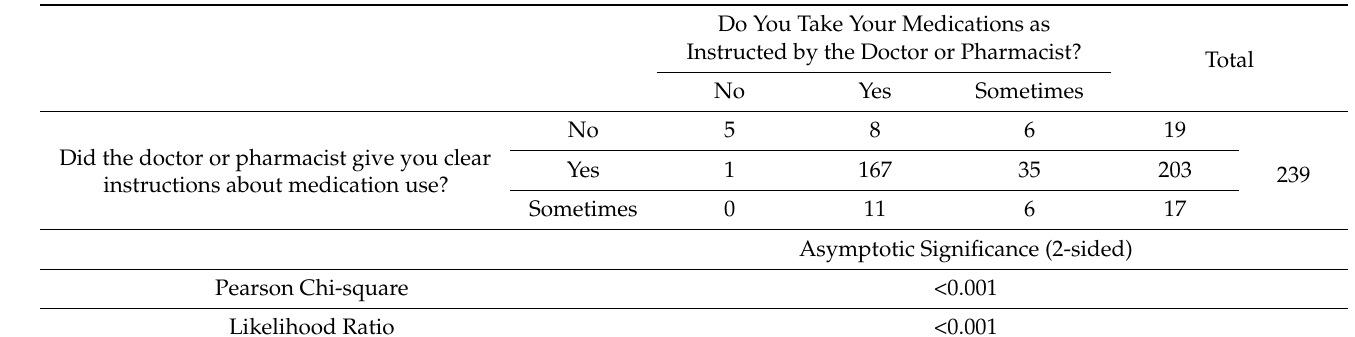
Table 5. Relationship between (1) taking medications as instructed by a healthcare provider and (2) the healthcare provider giving clear instructions about the medications used. Statistical significance was determined at a p -value of